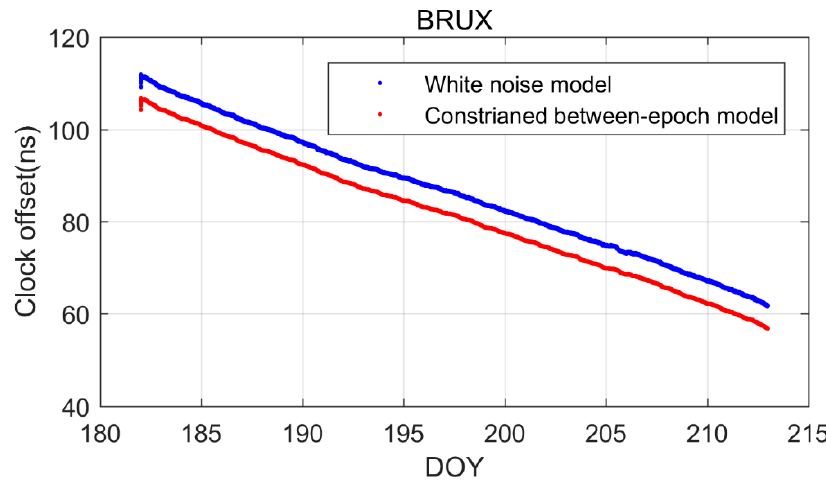
Figure 3. Clock offset time series using different models (red-5 ns).